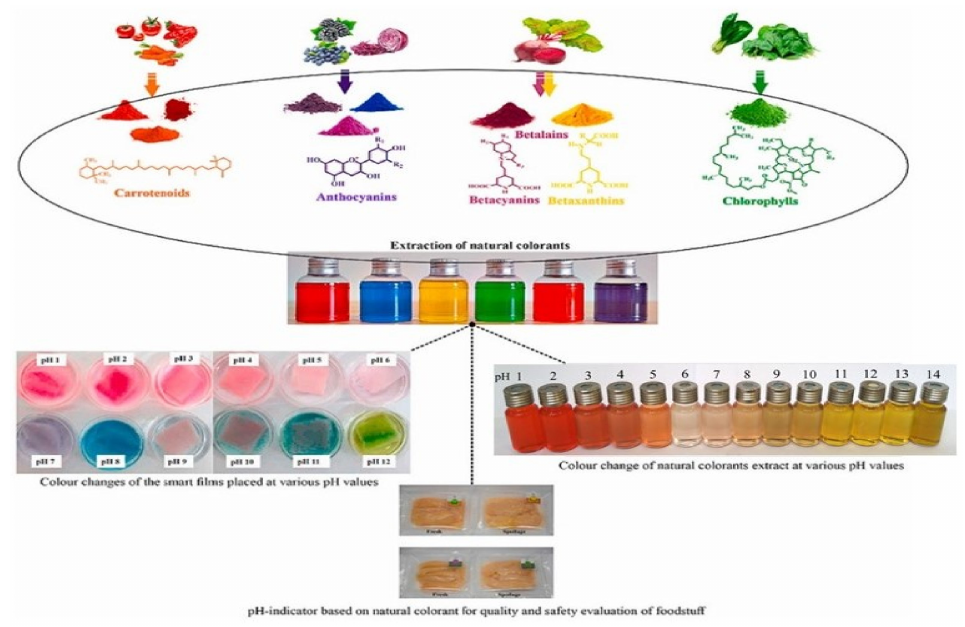
Figure 2. The color difference of natural colorants in various levels of pH range [53]. Anthocyanin is a natural phenolic indicator dye that can be extracted from several sources, such as red cabbage, blueberry, black soybean, raspberry, and purple cauliflower. It is soluble in water and appears red, pink, purple, green-yellow, and colorless depending on the pH [62]. There are various anthocyanin types, such as cyanidin, pelargonidin, peonidin, delphinidin, malvidin, and petunidin, consisting of 3-glucoside of the aglycone anthocyanidin, which is the sugar-free analog of anthocyanins [59]. The changes in the color of anthocyanin at different pH levels are due to the mechanism reaction of cations, such as flavylium cation (red pigment) that appears at strong acid conditions at pH < 4, carbinol and pseudo-base chalcone (colorless dye) appear at pH 4–6, quinoidal anhydrous- base (blue/purple pigment) appears at pH 6–8. Colorless chalcone (light-yellow pigment) appears at pH > 8 [63]. In addition, the substitution configuration of anthocyanin also leads to the color changes of anthocyanin. For example, increasing methoxy groups will generate a reddish color, while hydroxy groups will generate bluish color [59]. Incorporating